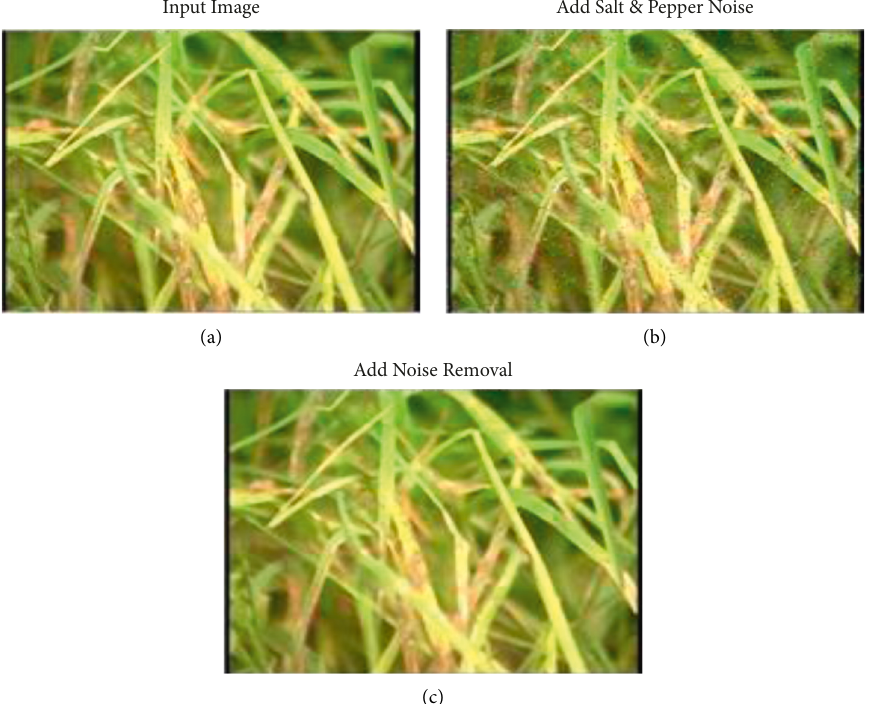
Figure 8: Results of salt and pepper noise. (a) Input image of rice blast. (b) Denoised image. (c) Image obtained after denoised by salt and